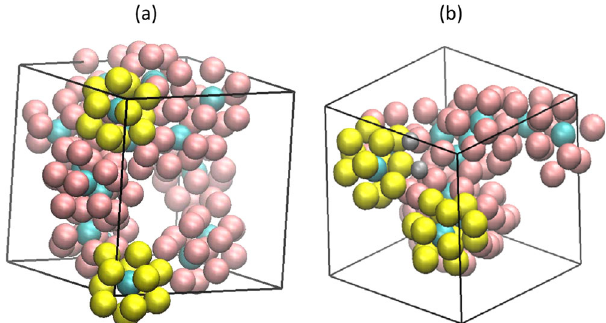
Fig. 9 Snapshots of the simulation for: a Al − Cr binary alloy where nearest-neighbor environment of Cr atoms, extracted from an equilibrium con fi guration obtained in the AIMD simulation at T = 800 K, are shown. They consist in 160 atoms out of the 256 atoms simulation box, namely 142 Al atoms in dark pink and 18 Cr atoms in blue. b Al − Zn − Cr ternary alloy where also nearest-neighbor environment of Cr atoms, extracted from an equilibrium con fi gura- tion obtained in the AIMD simulation at T = 800 K, are shown. They consist in 146 atoms out of the 256 atoms with 124 Al, 4 Zn, and 18 Cr atoms, resulting in a local composition Al 85 Zn 3 Cr 12 . For both panels, Al, Zn, and Cr atoms are drawn, respectively, in dark pink , gray , and blue color . Moreover, Al atoms in two typical Cr-centered icosahedra are highlighted in yellow for visual purpose. Some of the atoms in the con fi guration are shown outside the simulation cell